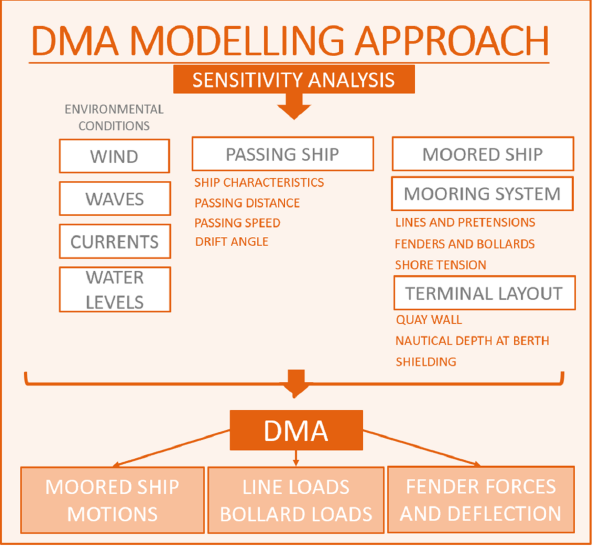
Figure 1. DMA modeling